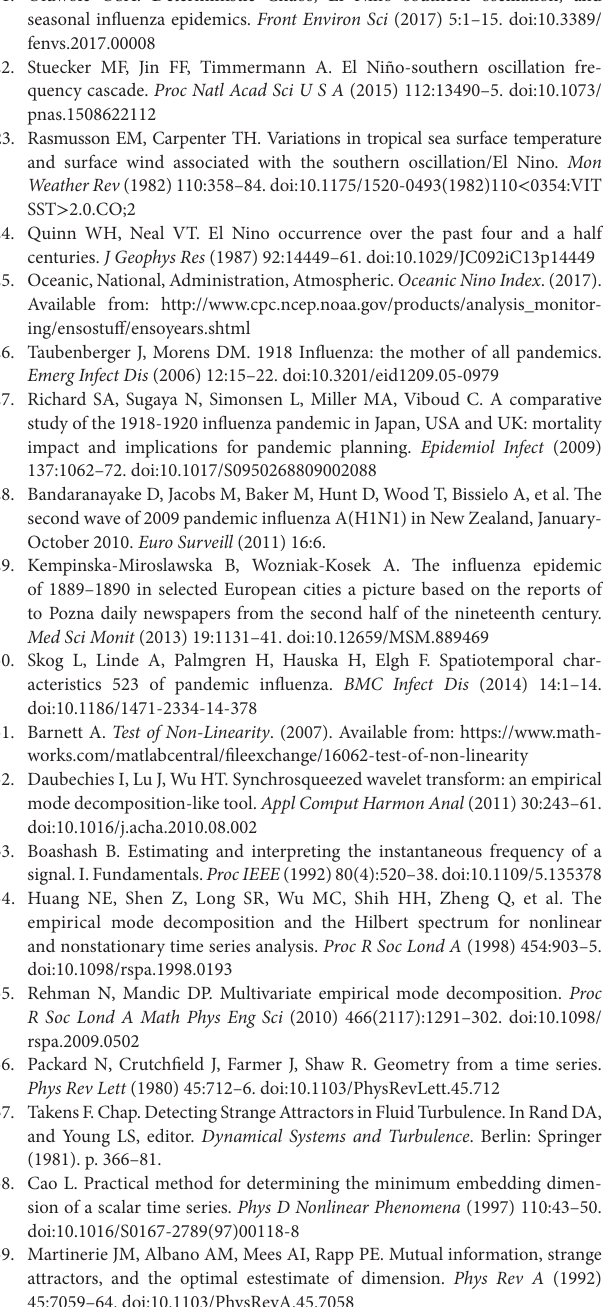
FigUre s2 | Time-dependent recurrence quantification for southern oscillation. Plots of determinism, divergence, laminarity, and trapping time are compared. FigUre s3 | Time-dependent recurrence quantification for sea surface temperature. Plots of determinism, divergence, laminarity, and trapping time are compared. FigUre s4 | Powerlaw distributions of network degree centrality. Degree centrality of joint southern oscillation and sea surface temperature network is shown in (a) , of El Nino network in (B) , and of La Nina network in (c)